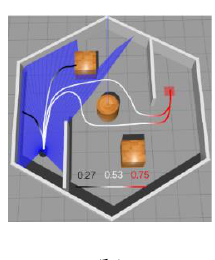
Figure 5. Matching network error and accuracy curve.